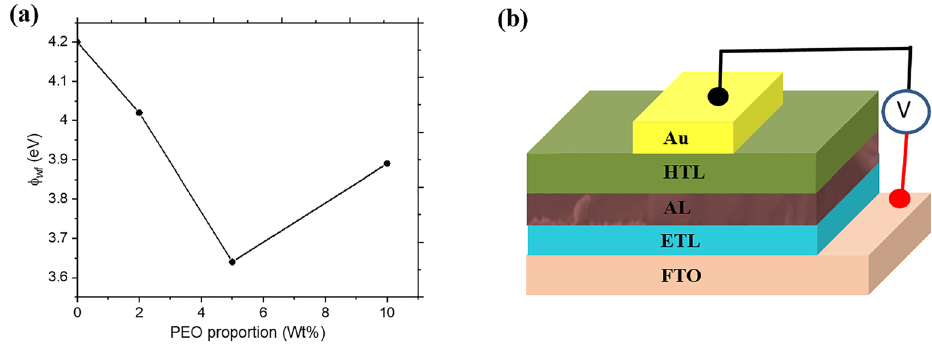
Figure 7. ( a ) Work function of perovskite films as a function of the weight proportions of PEO. ( b ) Architecture of the fabricated PSC